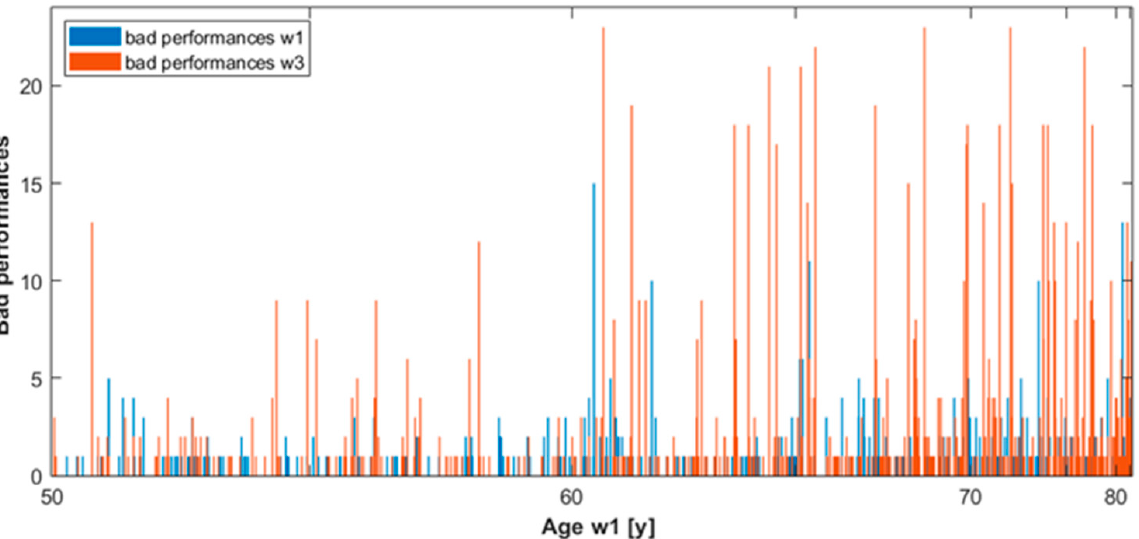
Figure 4. Histograms of the distribution of the variable bad performances for each participant at waves 1 (blue) and 3 (red).